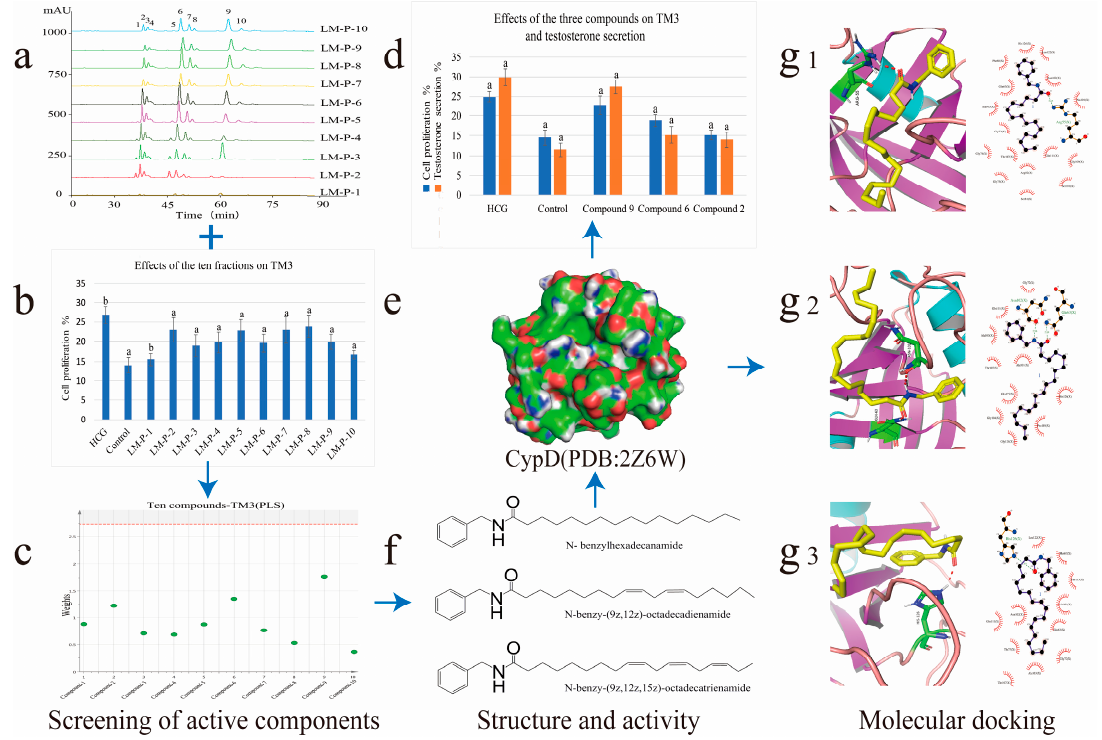
Figure 1. Strategy based on high-performance liquid chromatography-electrospray ionization / mass spectrometry (HPLC-ESI-MS / MS) coupling with the multivariate statistical analysis method to screen and identify the bioactive ingredients for the proliferation of mouse leydig cells (TM3) and promoting testosterone secretion in Lepidium meyenii . Molecular docking was used to investigate the mechanism of bioactive compounds. ( a ) The HPLC fingerprints of ten fractions. ( b ) E ff ects of the ten fractions